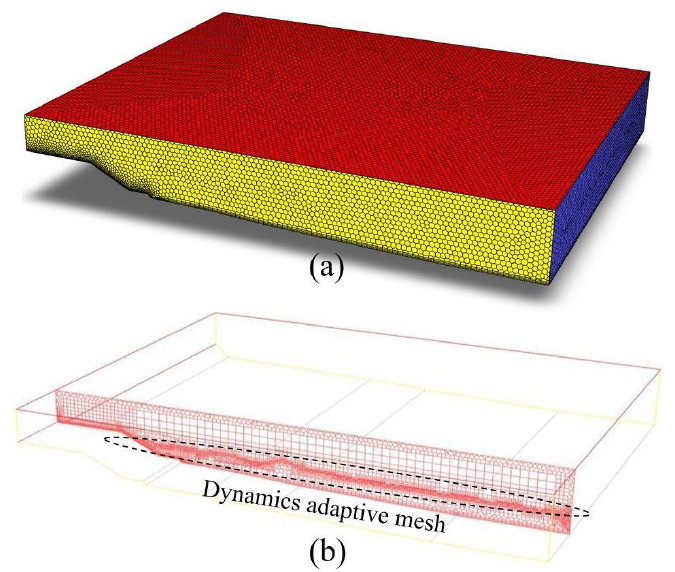
Figure 8. A sample of mesh model viewed from ( a ) outside and ( b )